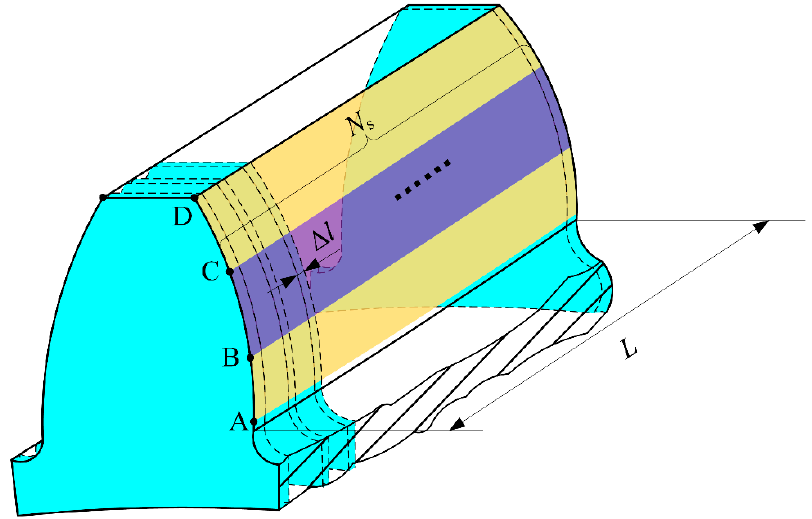
Figure 10. Sliced gear model.